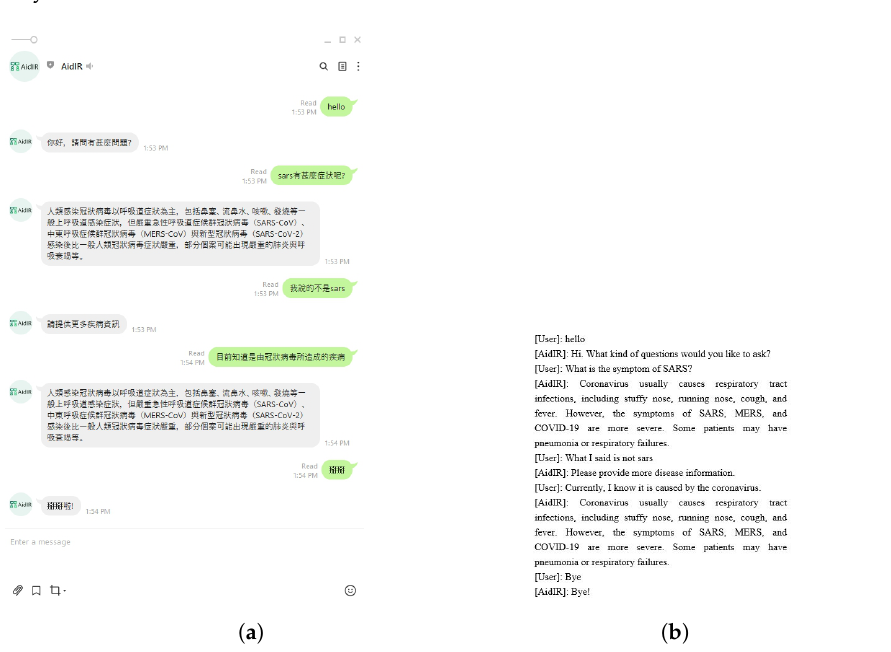
Figure 15. Error information included in rejection dialog: ( a ) original dialog; and ( b ) dialog in English.